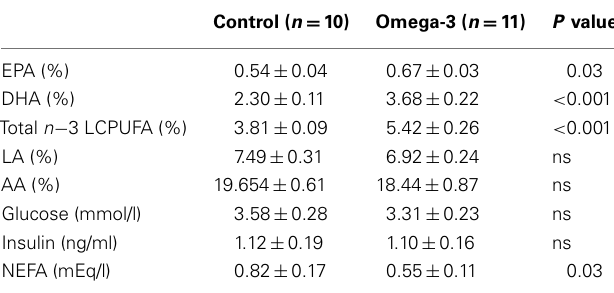
Table 2 | Maternal erythrocyte phospholipid fatty acid composition expressed as a percentage of total fatty acids and glucose, insulin, and NEFA concentrations at the end of lactation in Control and Omega-3